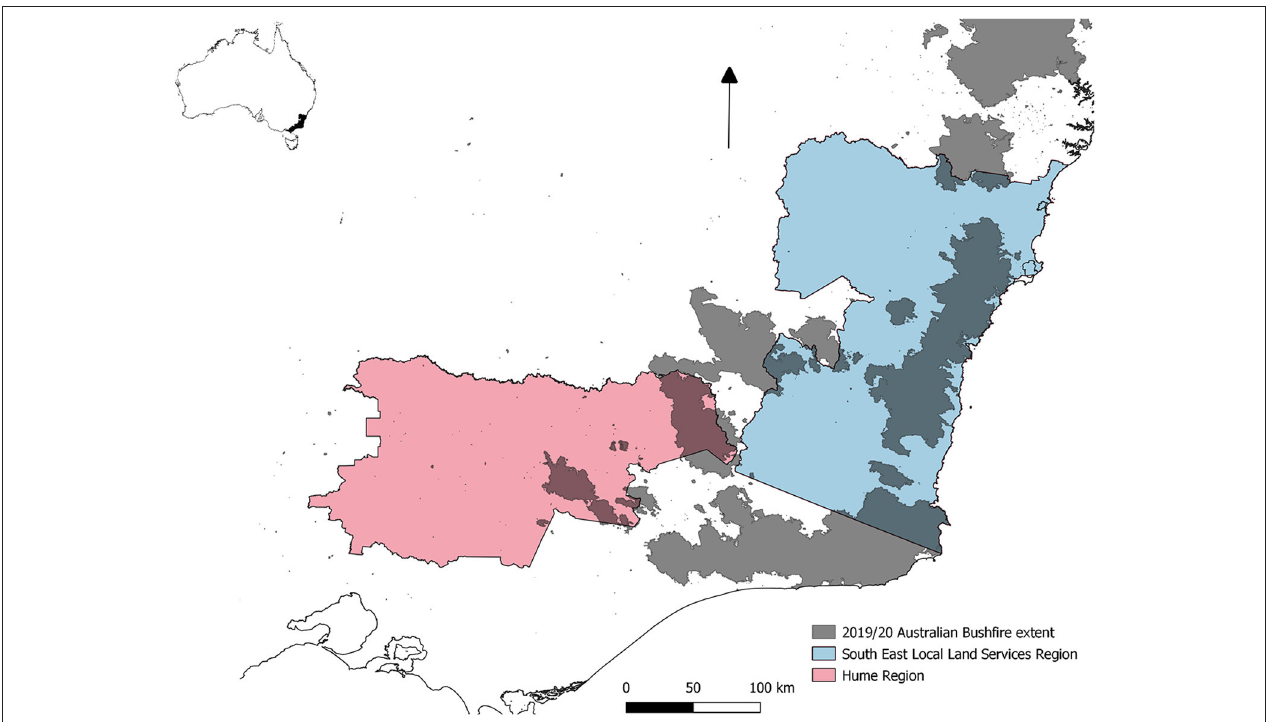
FIGURE 1 | A map displaying the two regions of Australia where the study occurred with bushfire extent overlaid. The location of the study site within the Australian continent is